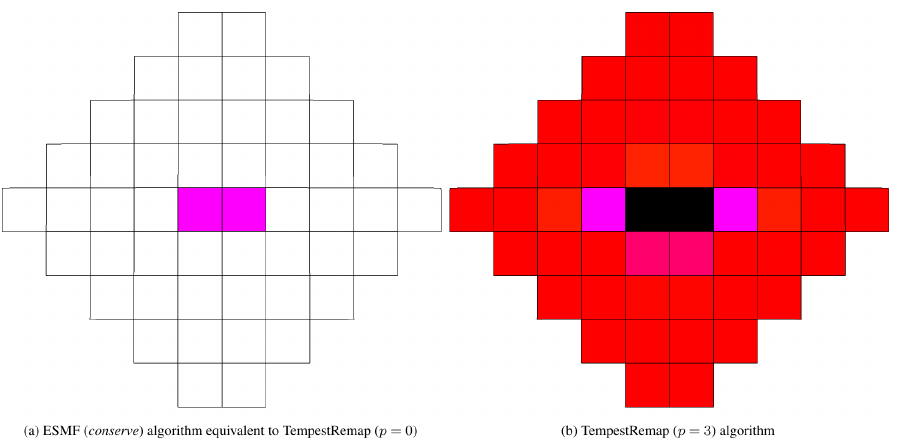
Figure 15. Comparison of source field reconstructions showing DoF coupling in linear maps when utilizing different remapping algorithms and degrees of